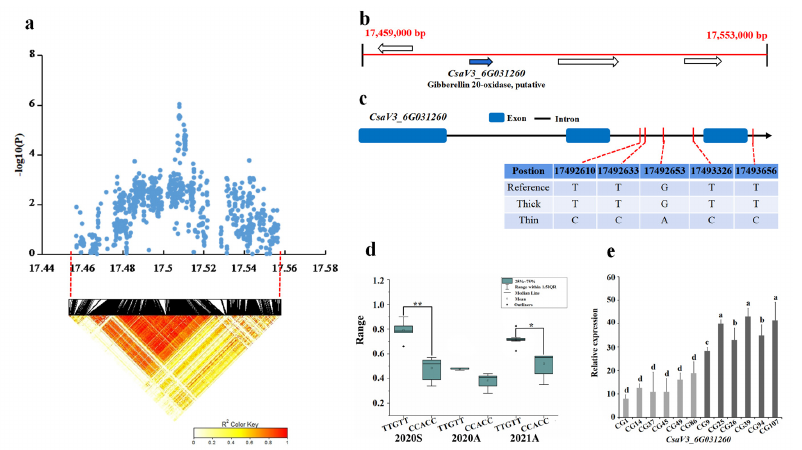
Figure 8. Identification of the stem diameter-related gene at locus gSD6.1 . ( a ) Manhattan map of near 100 kb ( top ) and LD heatmap ( bottom ) surrounding the peak of gSD6.1 . ( b ) Four genes predicted in the LD block region. Blue represents the genes that are different. ( c ) SNP variation of the candidate gene CsaV3_6G031260 among thick and thin stem lines (Table S6). ( d ) Haplotype difference of CsaV3_6G031260 . *** indicatess significance p < 0.001. ** indicatess significance p < 0.01. * indicatess significance p < 0.05. ( e ) Relative expression analysis of CsaV3_6G031260 . Gray column represents the thin stem samples (CG1, CG14, CG37, CG45, CG49, CG86); Black column represents thick stem samples (CG9, CG25, CG26, CG39, CG94, CG107). a,b,c and d represent the level of significant difference from high to